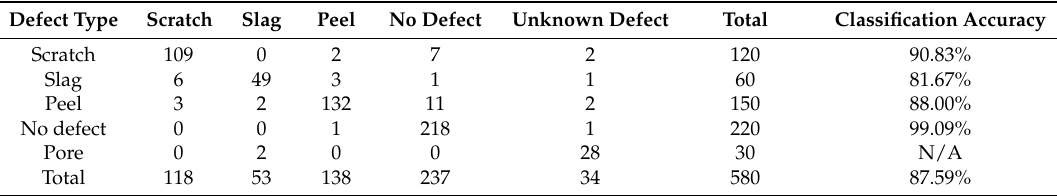
Table 9. Confusion matrix with the addition of pores defect .